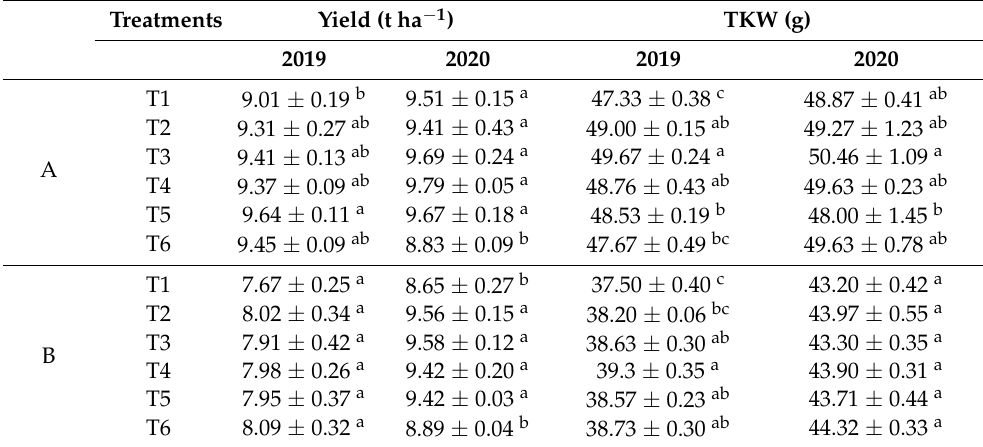
Table 4. Yield and thousand-grain weight (TKW) in cultivar with blue aleurone KM-72-18 (A) and a multi-row spike KM-94-18 (B) in 2019 and 2020 for single treatments of the stand (T1–T6). Means ± SE; n = 3; LSD post hoc test. Different letters are significantly different at p < 0.05. Treatments Yield (t ha − 1 ) TKW